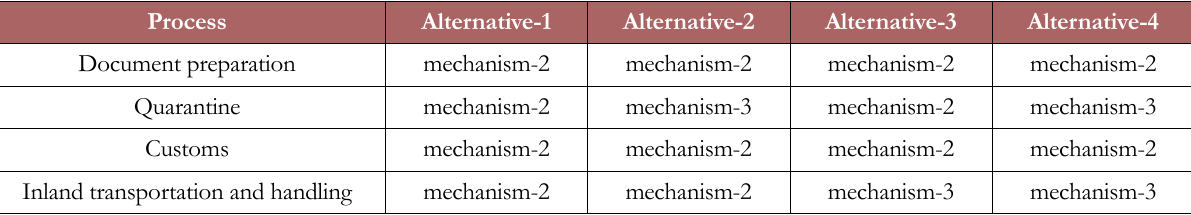
Table 4. Alternative